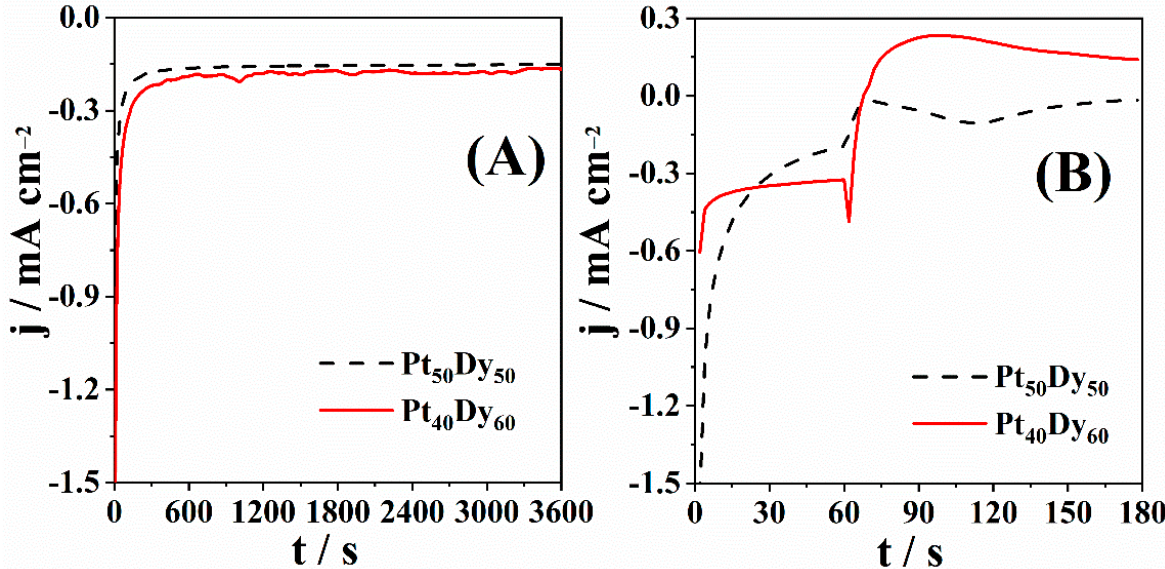
Figure 3. ( A ) Chronoamperometric curves of the Pt–Dy alloy electrodes in O 2 -saturated 1 M NaOH for 1 h at 0.77 V at 25 °C and ( B ) with the addition of fuel solution (0.03 M NaBH 4 ) at 0.77 V.